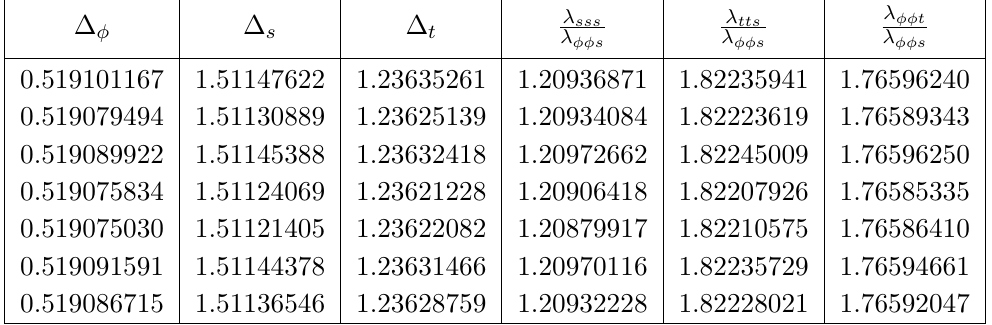
Table 9 . Allowed points in the (cid:3) = 43 island used for computing upper and lower bounds on C T , C J , and (cid:21) (cid:30)(cid:30)s .